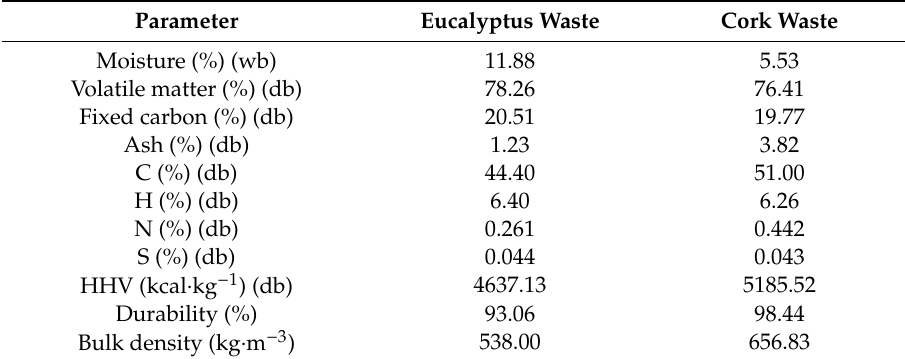
Table 5. Characteristics of the pellets that were analyzed.